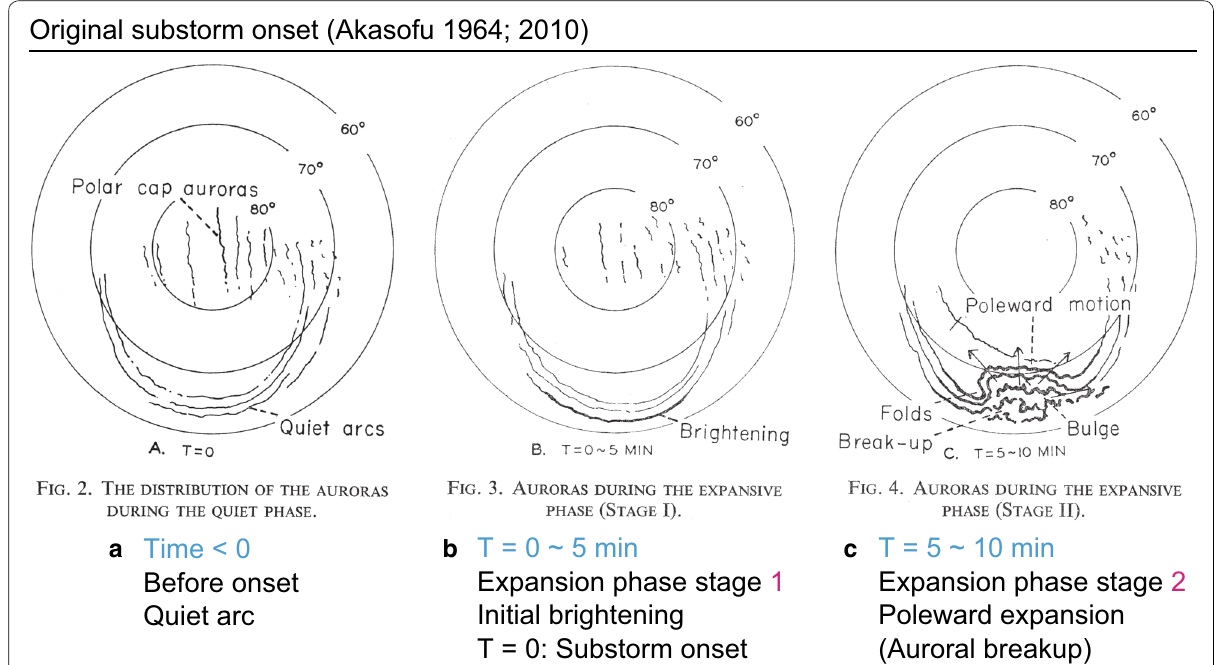
Fig. 1 Original illustrations and figure captions of the Akasofu substorm onset (Akasofu 1964). Reprinted with permission from Elsevier. Clarifications are added on the bottom of the figure. The illustrated time sequence was proposed on the basis of 1-min resolution ground all-sky images (ASIs). Auroral emissions in the polar ionosphere above 60 ◦ magnetic latitude are illustrated. T = 0 min represents the time of the